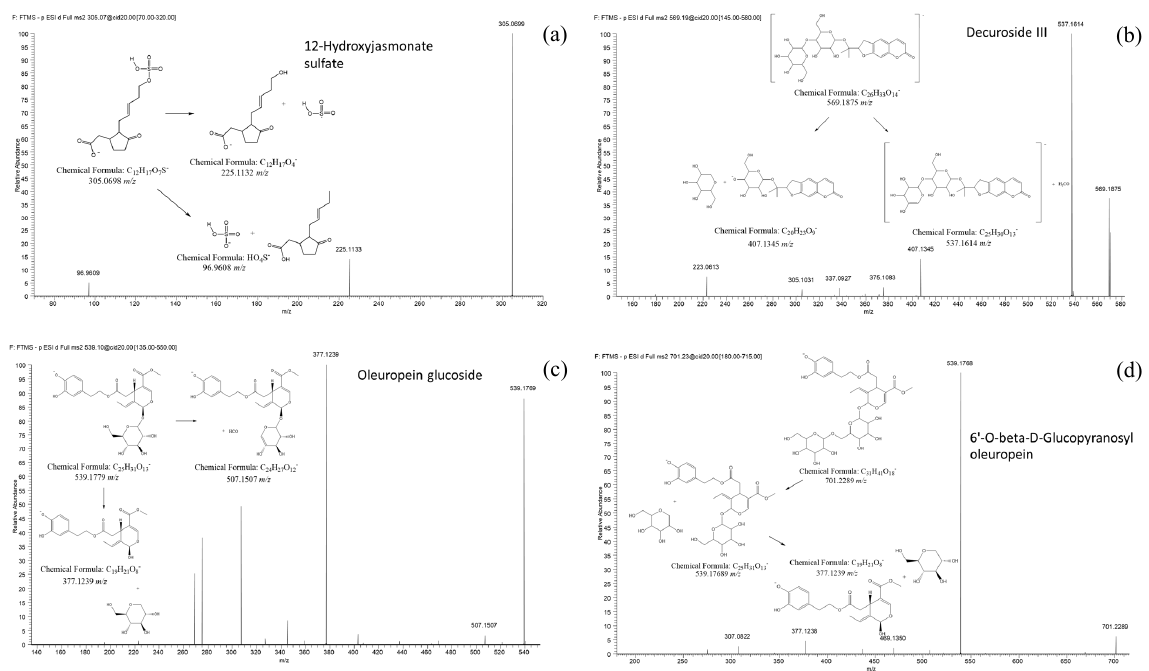
Figure 3. MS 2 spectra of some annotated features together with their fragmentation patterns: 12-Hydroxyjasmonate sulfate ( a ), Decuroside III ( b ), Oleuropein glucoside ( c ) and 6’-O-beta-D-Glucopyranosyl-oleuropein ( d ).